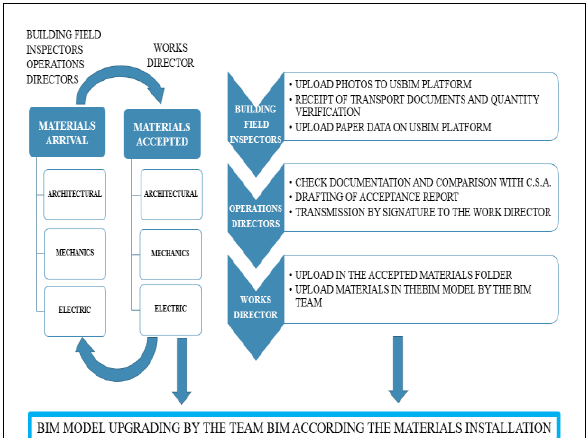
Figure 6 . The Procedure proposal scheme